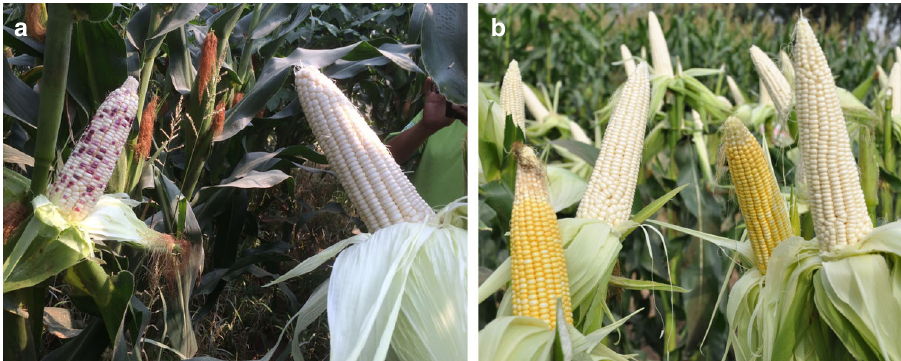
Fig. 4 Field testing the isolation of ga1 pollen from adjacent plants by Ga1 locus. a KYN3 ga1 (left) and its near isogenic line KYN3 Ga1-S (right) grown surrounded by a ga1 line with purple corn in Beijing, China. b KYN3 Ga1-S (white ears) was mingled with a ga1 line with yellow corn in Jilin,